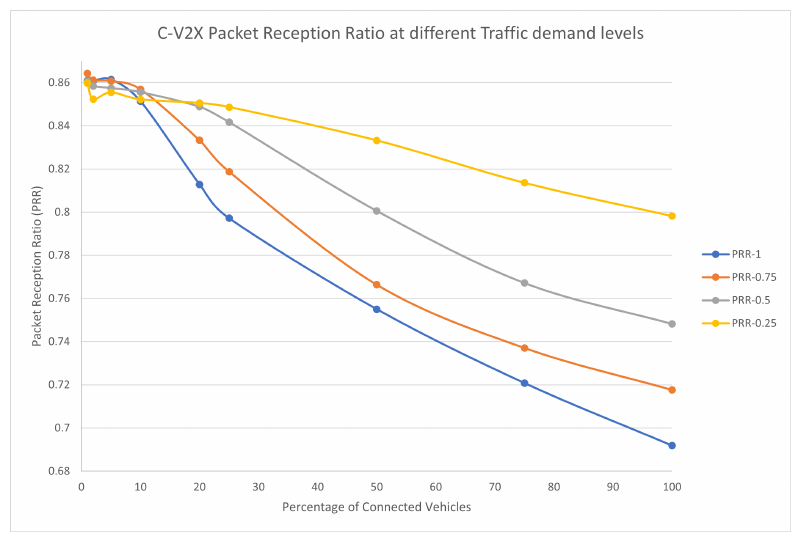
Figure 17. Average Packet Reception Ratio using C-V2X-based Energy-Efficient dynamic routing application in LA road network with different traffic demand scale